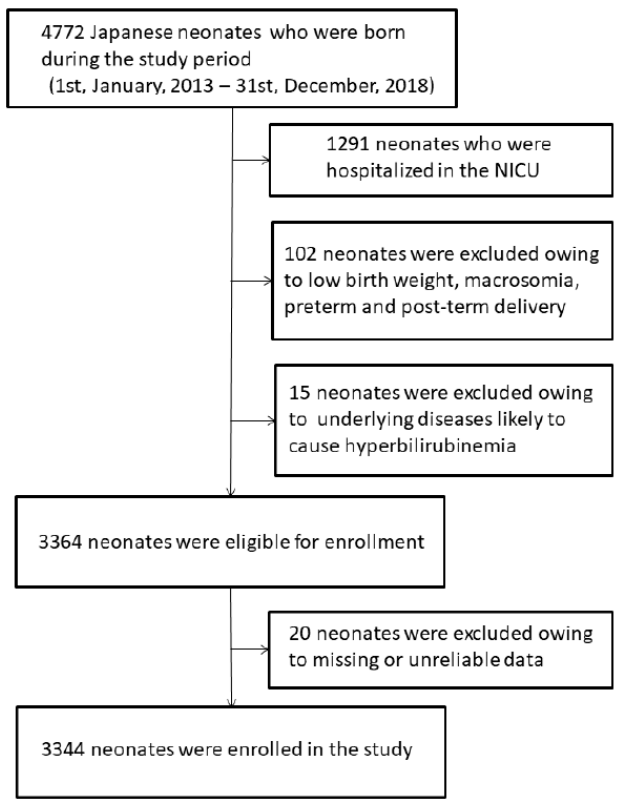
Figure 1. Flow chart of subject recruitment. NICU: neonatal intensive care